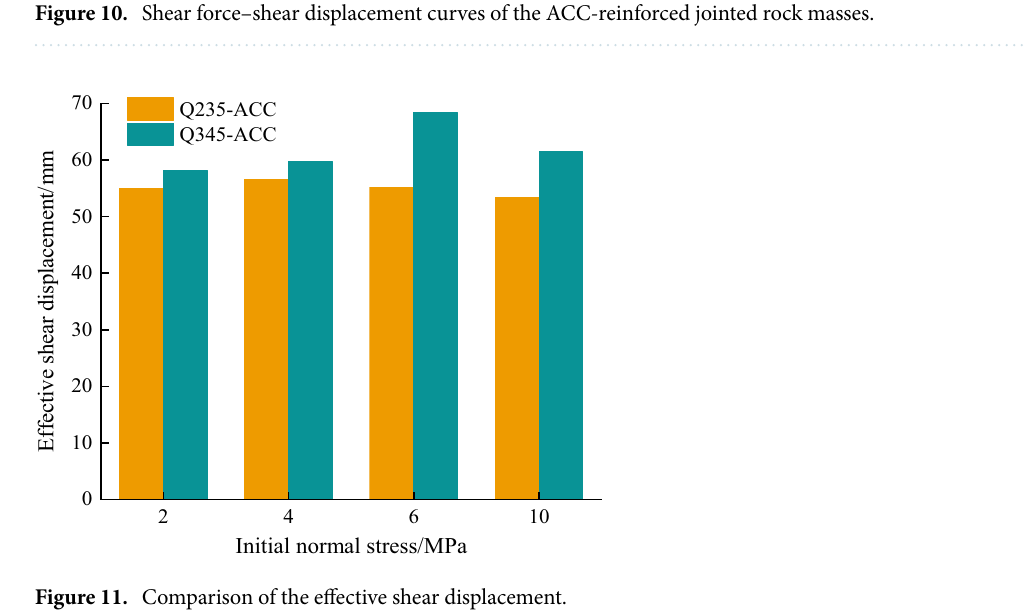
Figure 11. Comparison of the effective shear